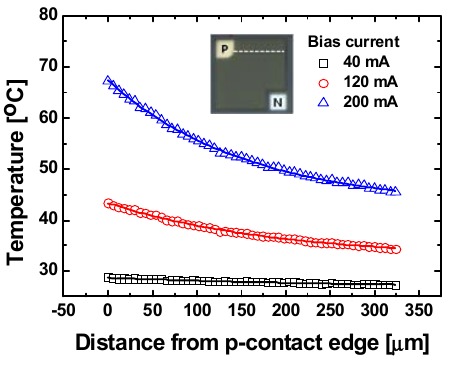
Figure 10. Temperature profiles for different bias currents along the line in the emitting area of the LED indicated in the inset. Solid line is an exponential decay